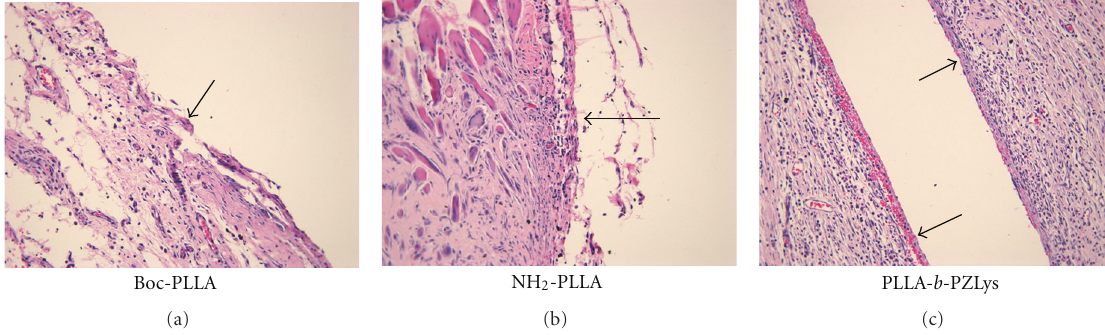
Figure 9: In vivo biocompatibility of the polymer films (interface surfaces are denoted by arrows). Table 1: Molecular weight characterization of BocNH-PLLA